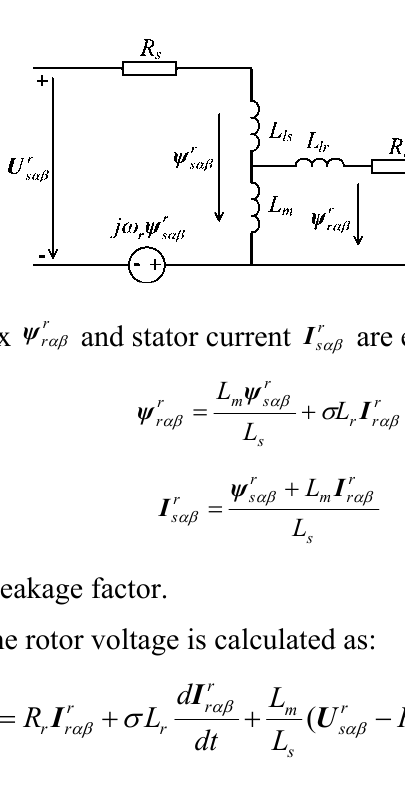
Figure 1. Equivalent circuit of a DFIG in an arbitrary reference frame rotating at a speed of ω r